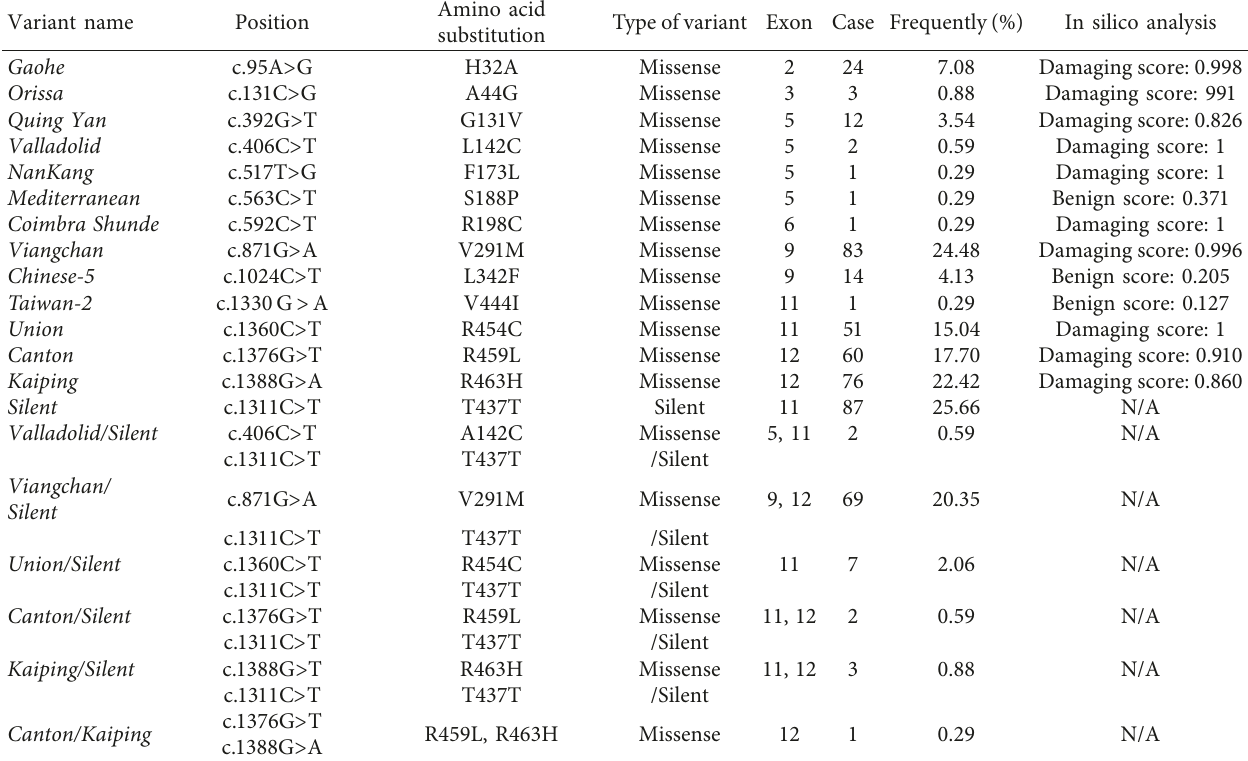
Table 2: Distribution of G6PD variants in this